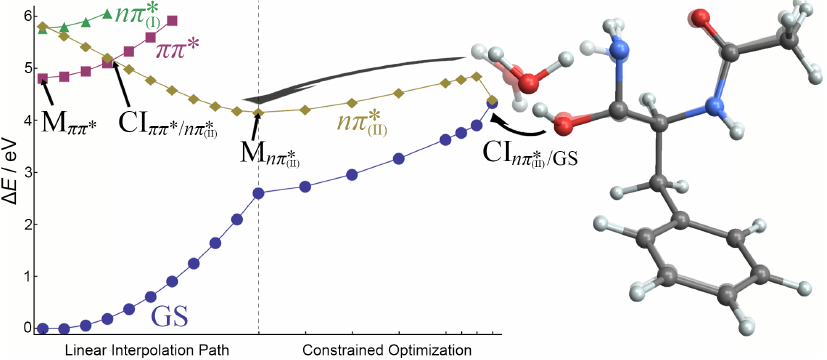
Figure 12. Energy profile showing the deactivation of NAPA B monohydrate. In the first part, the reaction path was obtained by linear interpolation between the M ππ ∗ and M ( II ) minima (left of the dashed line). In the second part, the energy profiles were obtained by constrained optimization of the − H bond n π ∗ state for fixed O H ( II ) 2 O